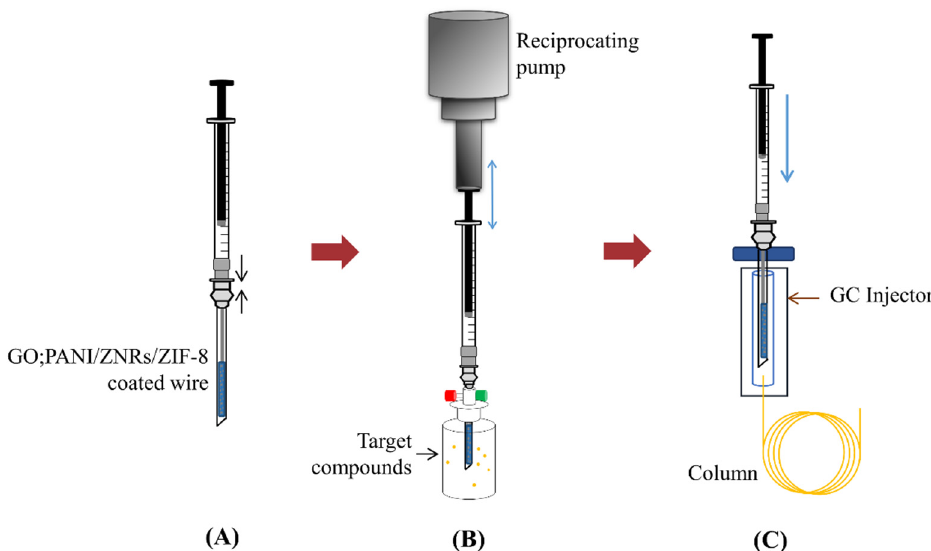
Figure 2. A scheme of INME process. ( A ) A needle inserted with a coated wire is connected to a gas tight syringe. ( B ) The needle was plugged into the mini-nut cap to adsorb target compounds in the headspace using a reciprocating pump. ( C ) The target compounds adsorbed on the adsorbent was thermally desorbed in GC injector and analyze using GC/MS.